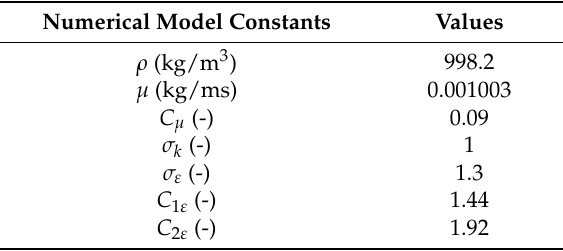
Table 2. Given and standard values for constant